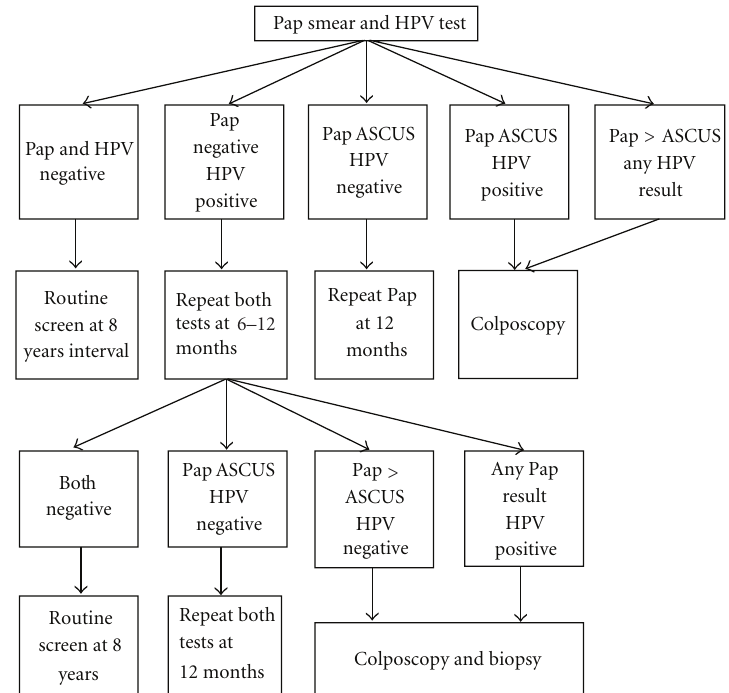
Figure 4: Schema for high-resource situations, starting with parallel testing with cytology & HPV DNA testing.